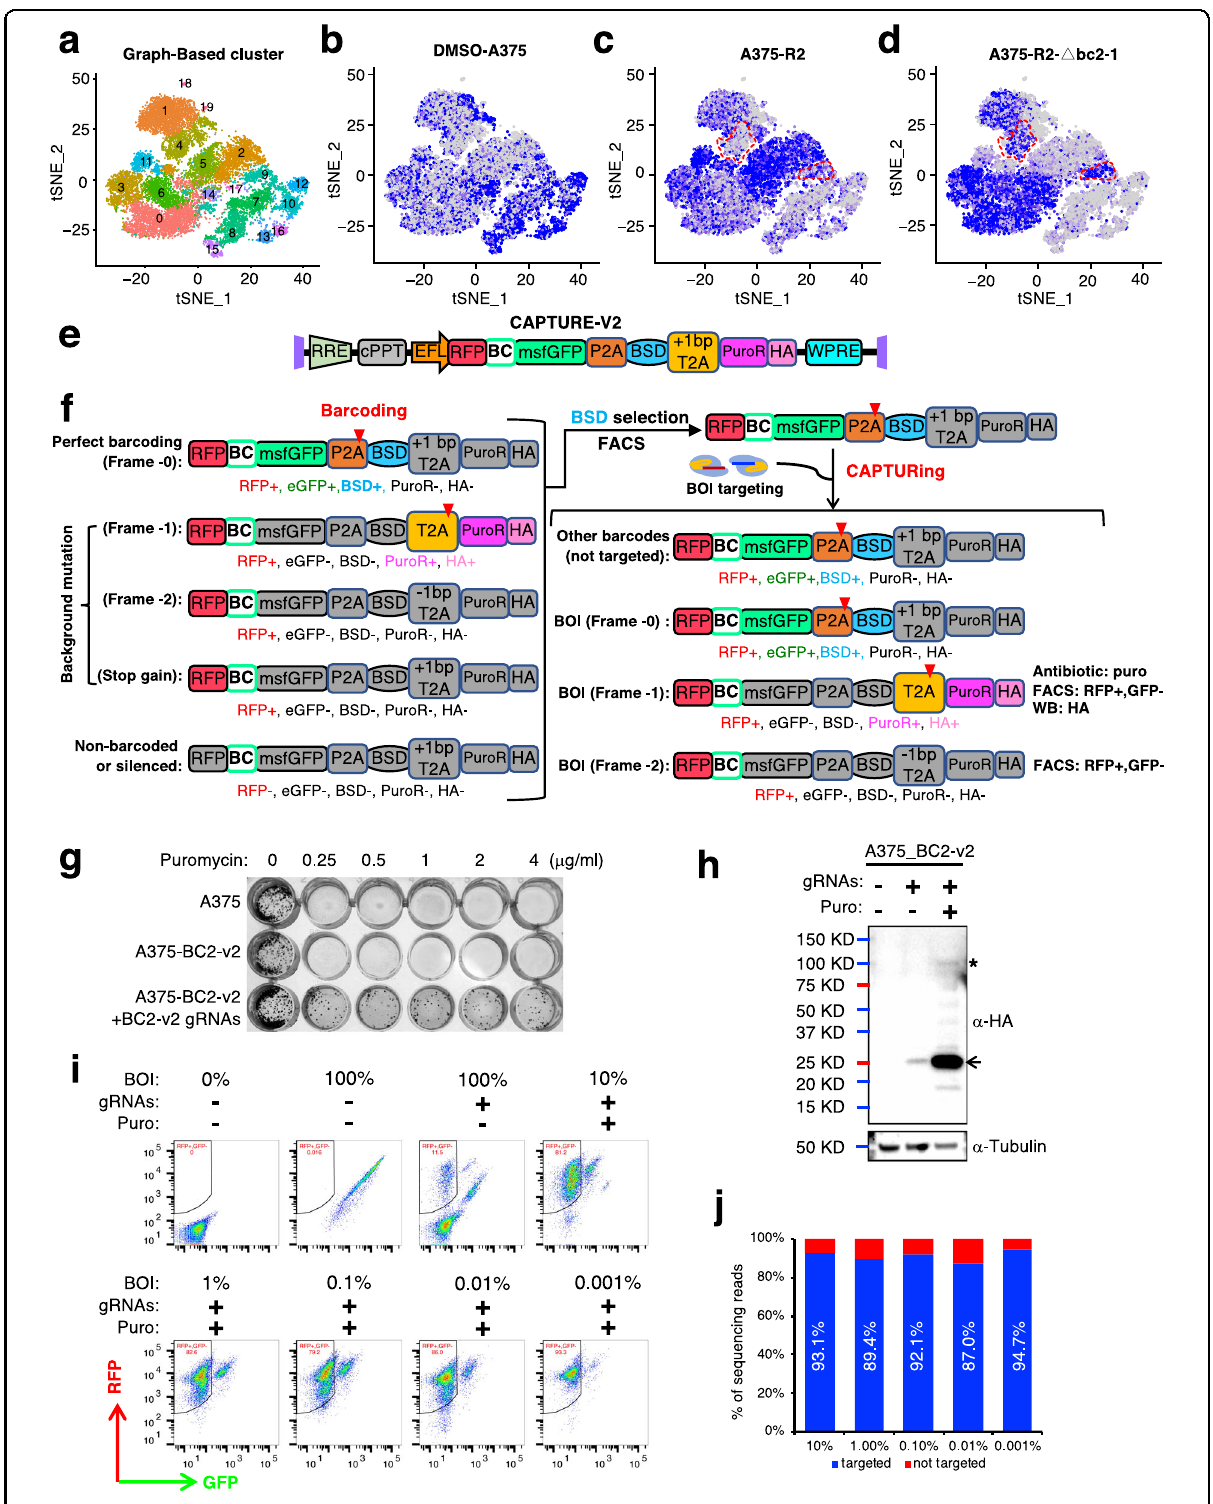
Fig. 7 (See legend on next